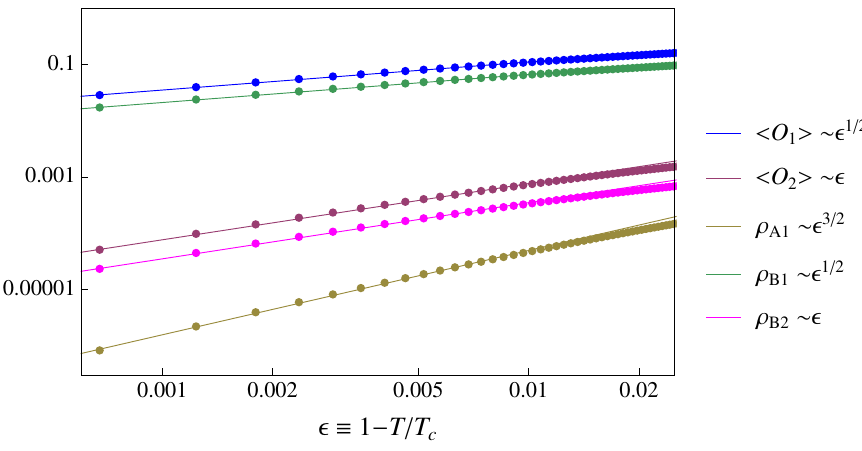
Figure 3 . The log-log plot of the VEVs near T c . Straight lines denote the expected scaling behaviors shown in (4.5), and dotted lines denote numerical values. We consider the model (5.1) with q B = 0 : 5 and k=(cid:22) = 1. The data at the top corresponds to h O 1 i and (cid:26) B 1 , the data in the middle to h O 2 i and (cid:26) B 2 , and at the bottom to (cid:26) A 1